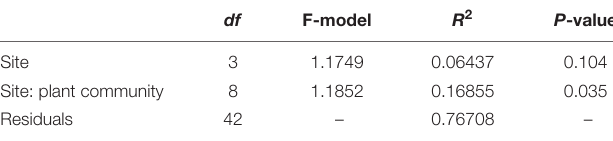
TABLE 2 | Results of PERMANOVA conducted on EMF community of balsam fir saplings. df F-model R 2